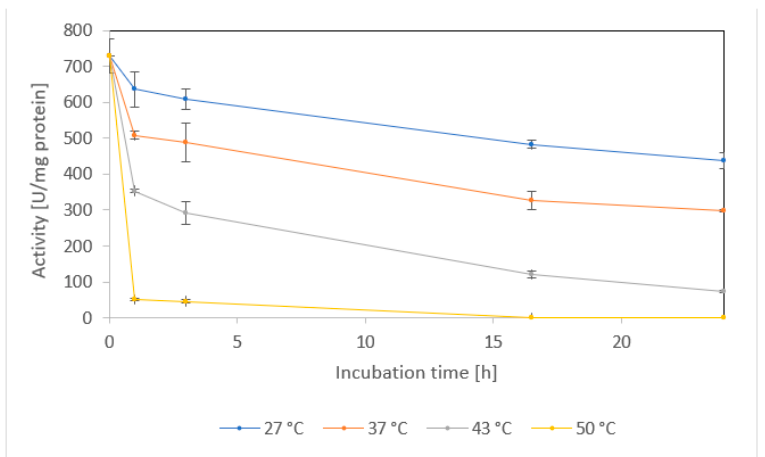
Figure 4. Temperature stability of enzyme NitEg. The purified enzyme (10.3 mg protein/mL) was incubated in 50 mM Tris/HCl buffer, pH 8.0, with 150 mM NaCl, at different temperatures without shaking. Specific activities were determined by the formamide assay.